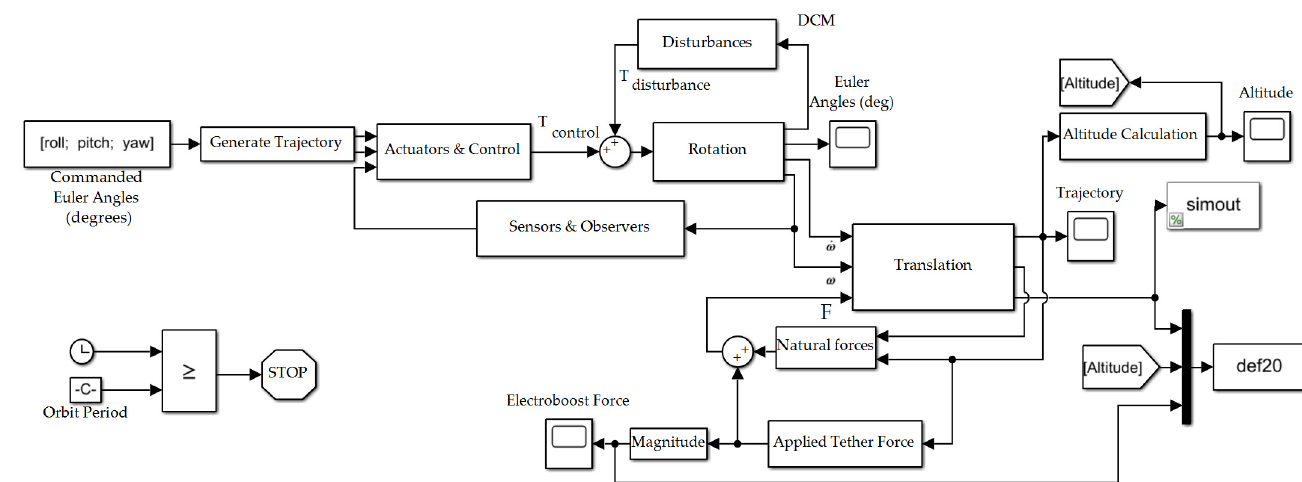
Figure A1. SIMULINK simulation created to validate proposals.